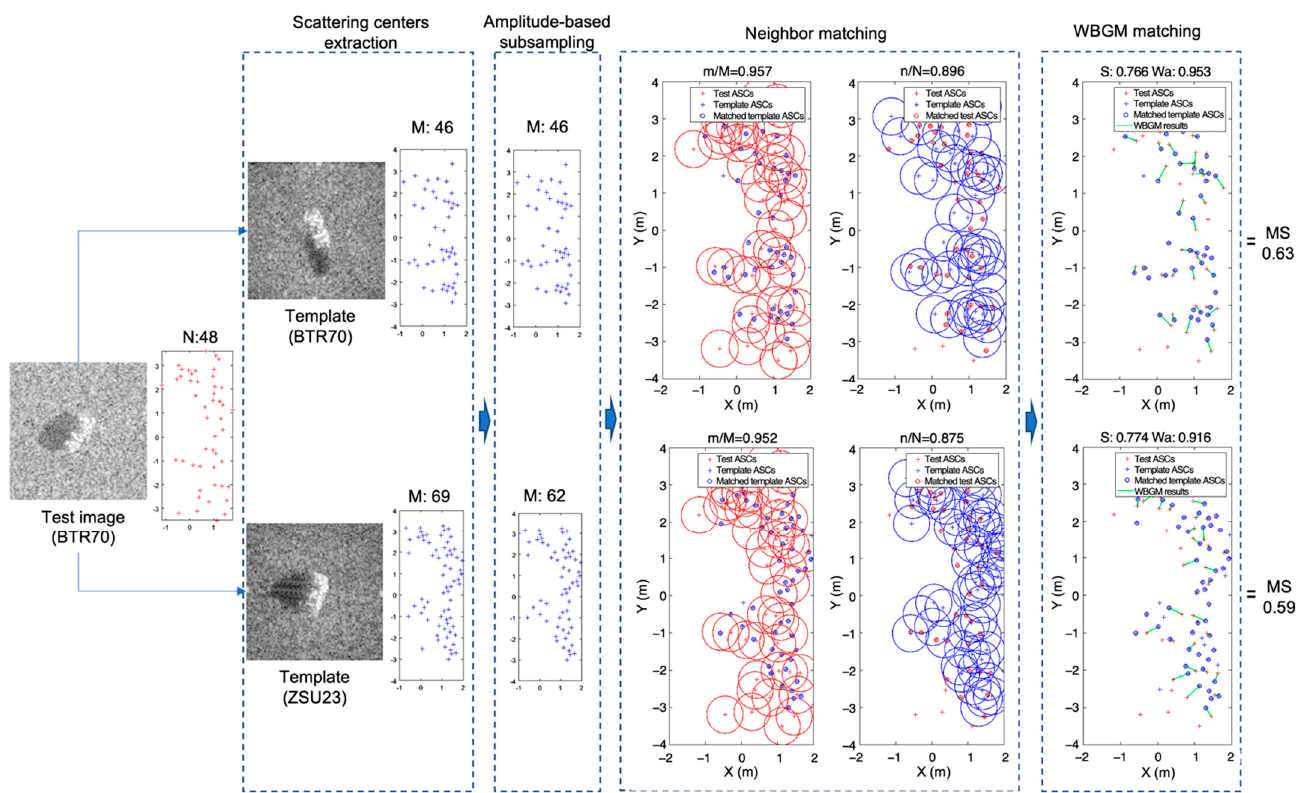
Figure 9. Example of recognition results obtained using the proposed algorithm.